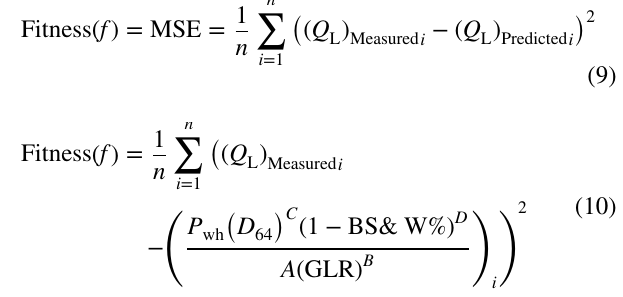
L(measured) versus parameter X calculated with Eq. (6) displaying the best-fit straight line (Eq. 7) and correlation